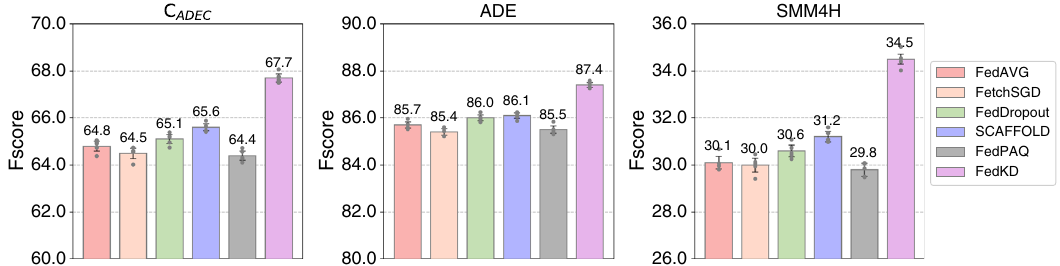
Fig. 1 Performance comparison of different federated learning methods in the medical NER task. The histogram height represents the Fscore of the corresponding method. The error bars represent the mean values with 95% con fi dence intervals ( n = 5 independent experiments). The results show that FedKD is more effective than other compared federated learning methods in handling non-IID data.